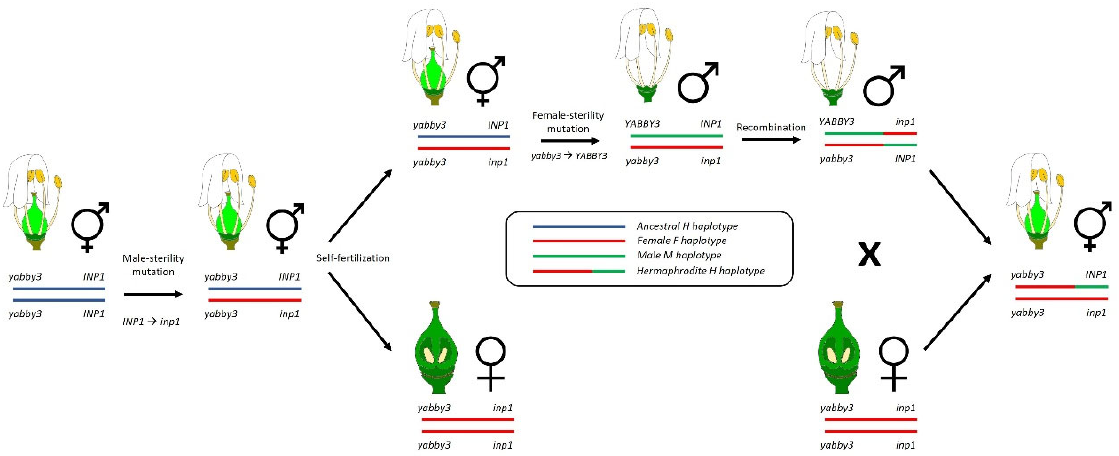
Figure 2. Schematic model of evolution of sex determination in grapevine. From left to right, a hermaphroditic ancestor gave rise to male ‐ sterility mutation at the INP1 locus to produce gynodioecious individuals. The recessive male ‐ sterility mutation is indicated as inp1 . Conversely, a dominant female ‐ sterility mutation at the YABBY3 locus originate male flowers. Based on a recent hypothesis [34], a rare recombination event occurred in a V. sylvestris male , leading to H haplotype and hermaphrodite individuals in domesticated V. vinifera cultivars. Adapted from ref. [23].